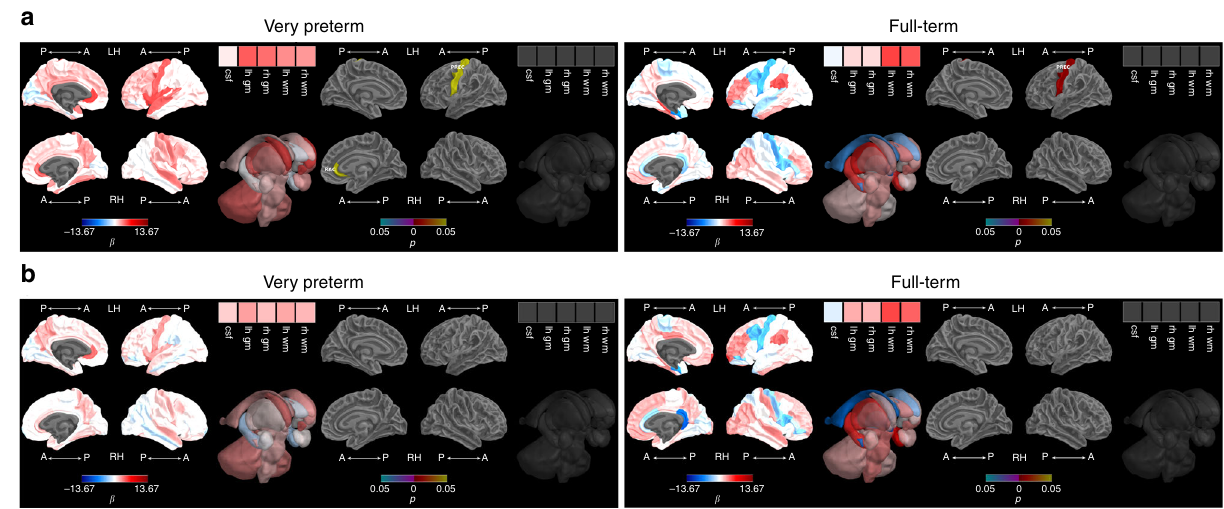
Fig. 4 Intelligence and brain growth from term-equivalent to 7 years. a Adjusting for sex and age at IQ assessment and b additionally adjusting for total brain volume growth and social risk. Note: IQ-by-time regression coef fi cients from linear regression models ( β ) in blue refer to negative associations (slower growth associated with higher IQ scores) and in red refer to positive associations (faster growth associated with higher IQ scores), with darker coloured regression coef fi cients indicating stronger associations; p values are false discovery rate corrected and darker coloured p values indicate stronger signi fi cance; Boxes in the top right corner of the fi gures represent global brain volumes. A = anterior, P = posterior, LH = left hemisphere, RH = right hemisphere, csf = cerebrospinal fl uid, gm = grey matter, wm = white matter, PREC = precentral, RAC = rostral anterior cingulate.